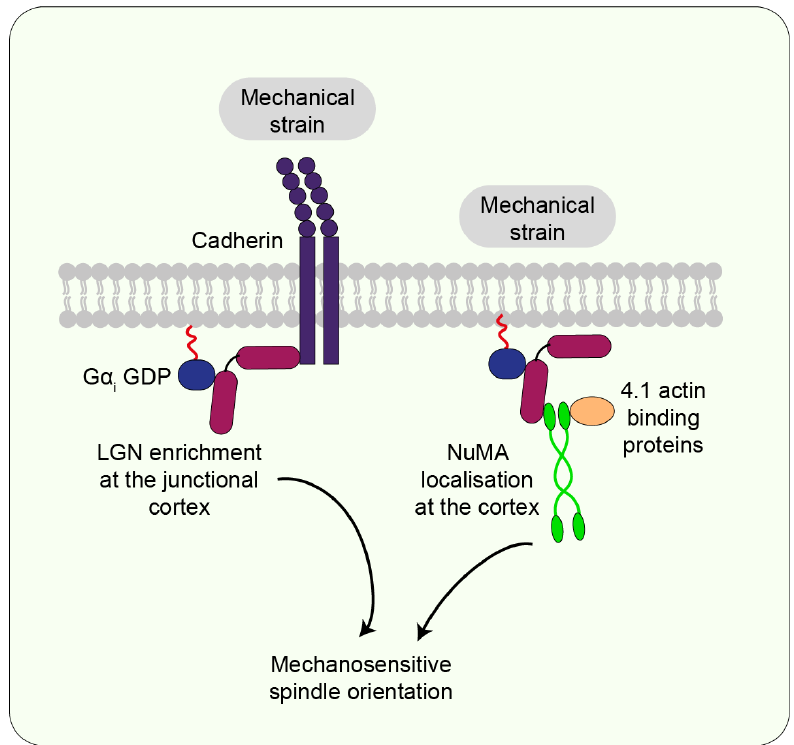
Figure 7. Mechanical forces direct the localisation of key cortical proteins to influence spindle orientation. Upon experiencing mechanical strain, cadherins promote the localisation of LGN to cell-cell contacts to regulate spindle orientation. Another spindle orientation core protein, NuMA, also localises to the cortex and potentially interacts with actin-binding proteins to influence mechanosensitive spindle positioning.